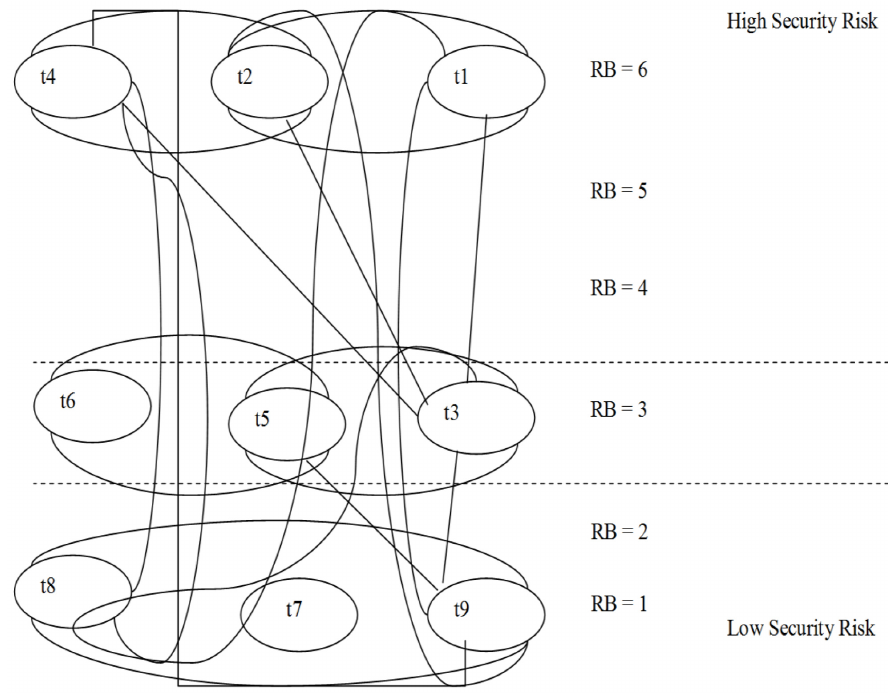
Figure 5. Risk Graph with Trust Delegation (Muthaiyah,